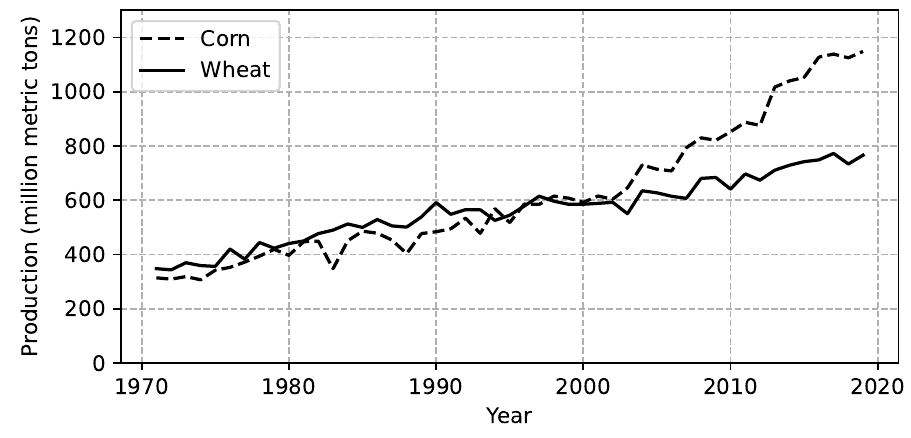
Figure 1. Annual global corn and wheat production in million metric tons,